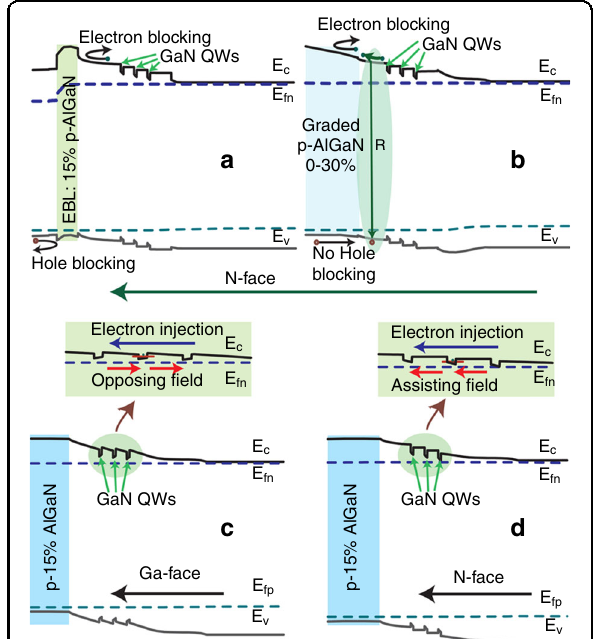
Fig. 8 Energy band diagrams of GaN/Al 0.15 Ga 0.85 N MQW. a LED of N-polar QW with traditional electron blocking layer and b with graded p-AlGaN (polarization-induced p-doping). c LED of Ga-face QW: polarization fi elds oppose electron injection. d LED of N-face QW: polarization fi elds assist carrier injection. Reprinted with permission from Verma et al. 151 . Copyright 2011 American Institute of